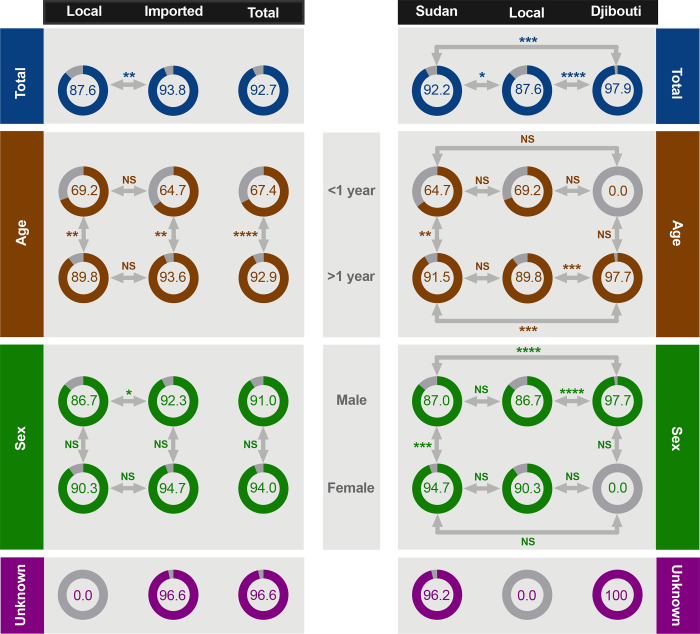
Seroprevalence rate in imported and local dromedary camels based on age and sex.Percentage of seroprevalence is shown for each category. ****p<0.0001, ***p <0.001, **p <0.01, *p <0.05 and NS denotes not statistically significant (Fisher Exact Test).